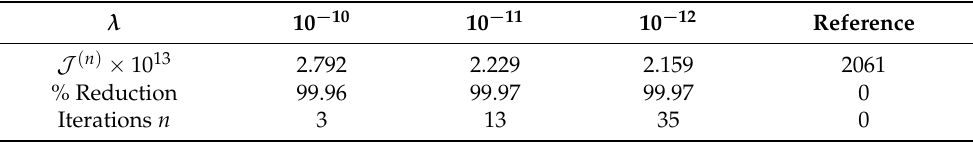
u , | | ( n ) , percentage J